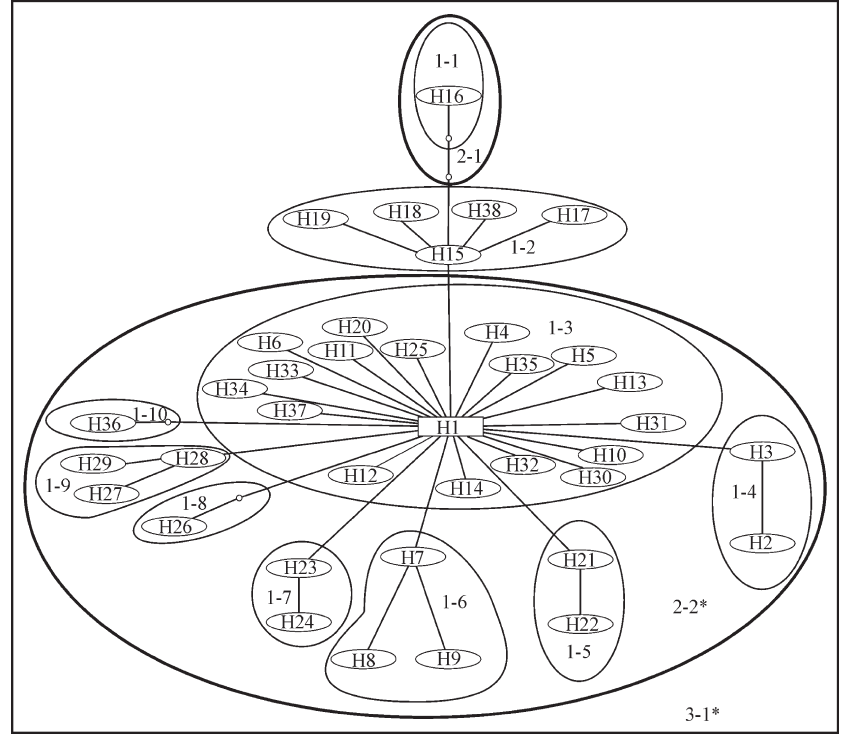
Figure 2 - Most parsimonious network of 38 mtDNA haplotypes detected in the sample of 125 individuals of C. crocodilus . Lines represent one mutational step, circles represent haplotypes. The one square represents the most likely ancestral haplotype. Empty circles represent inferred, but not de- tected haplotypes. * indicates a significant nesting level inferred in NCA.